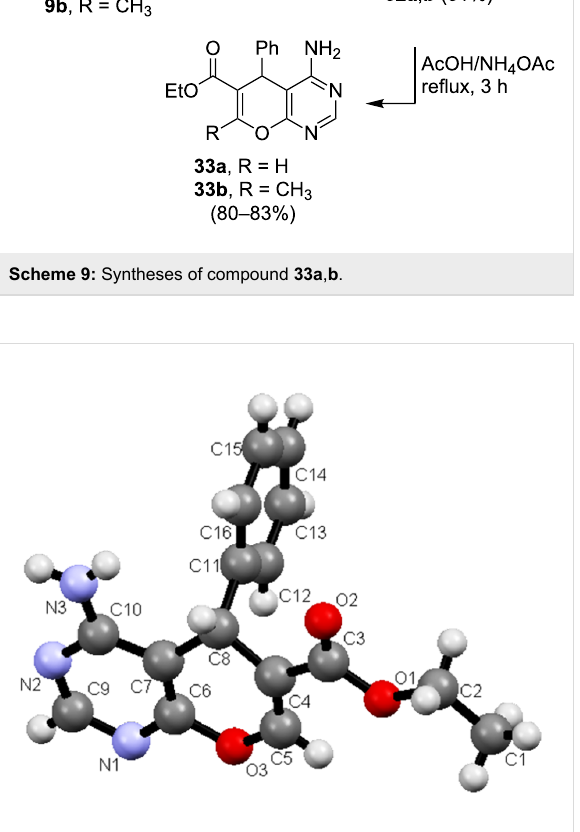
Figure 10: X-ray crystal structure of 33a